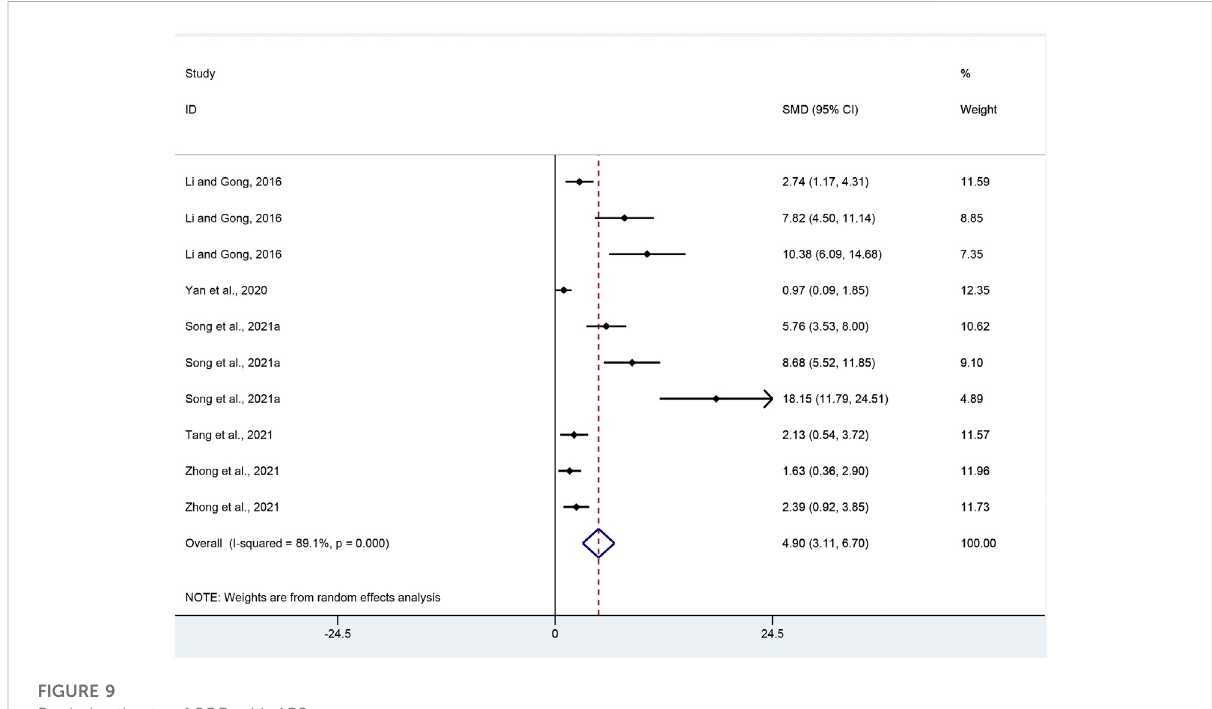
FIGURE 9 Pooled estimate of SOD with APS.